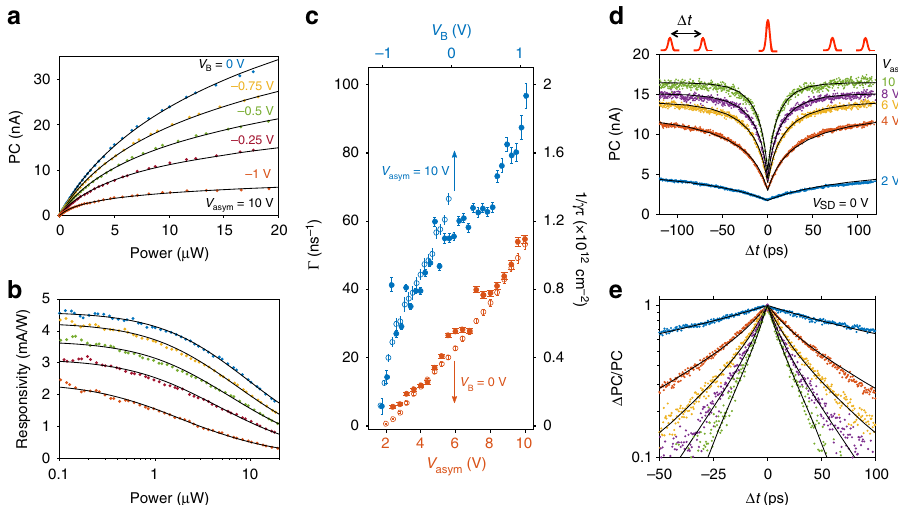
Fig. 3 Determination of the photoresponse time τ by nonlinear and time-resolved photocurrent measurements. a PC vs. laser power P for various V B , at = 10 V and h υ = 1.65 eV. b Responsivity (PC/ P ) in the same conditions as a . The solid black lines in a and b are fi ts to the data of PC / ln 1 þ γτ N ð Þ . V 0 asym c Photoresponse rate Γ ¼ 1 τ ( fi lled circles, left axis) obtained from the TRPC measurements (shown in d , e and Supplementary Fig. 10d) and Γ γ ¼ 1 γτ (open circles, right axis) obtained from the power dependence measurements (shown in a , b and Supplementary Fig. 10a) as a function of V asym at V B = 0 V (orange, lower axis) and V B at V asym = 10 V (blue, top axis). Good agreement between TPRC and nonlinear PC measurements is found for an EEA rate of γ = 0.05 cm 2 s − 1 . The error bars correspond to the standard deviations obtained from the fi ts. d PC as a function of time delay Δ t between two pulses (illustrated above the plot) at various value of V asym , with time-averaged P = 100 µ W and V B = 0 V. e Same data as in d but plotted with the normalized Δ PC fi ts to the data using the model described in the Supplementary Note Þ . The solid black lines in d and e are